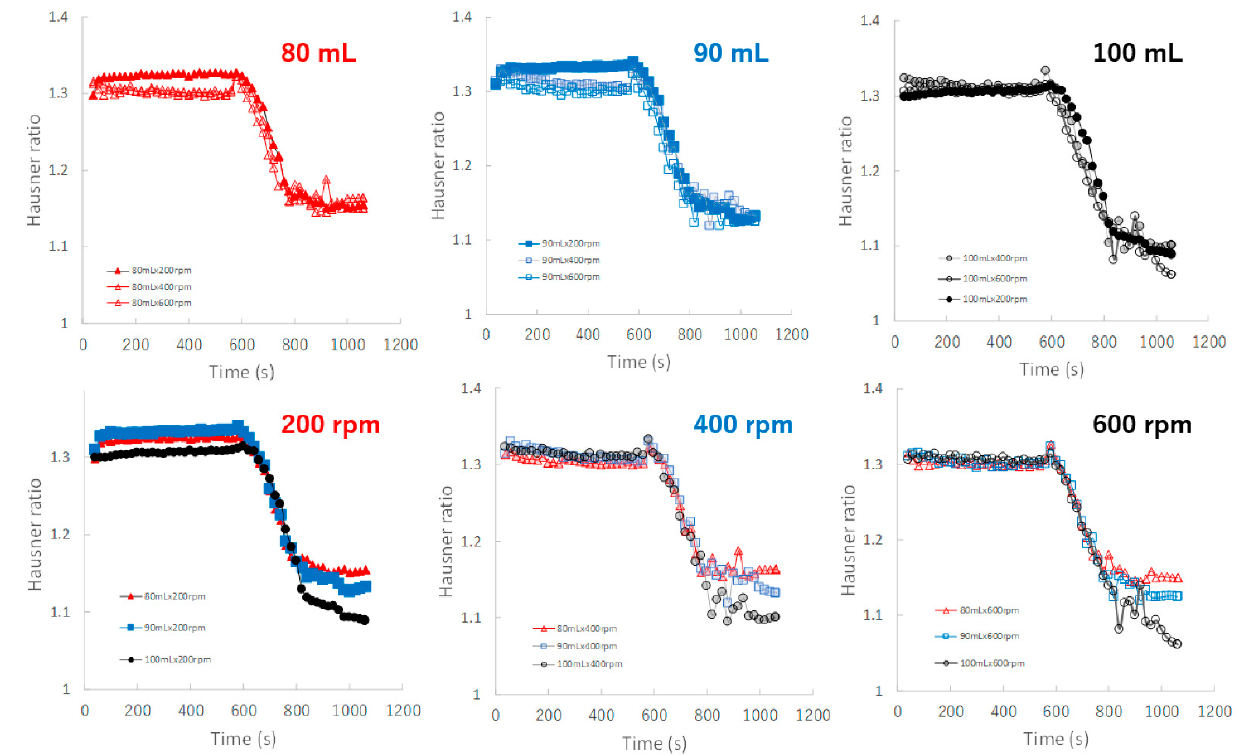
Figure 10. The effect of adding water and increasing stirring speed on real-time HR profiles of the granules predicted using the NIRS/PLSR method. granules predicted using the NIRS/PLSR